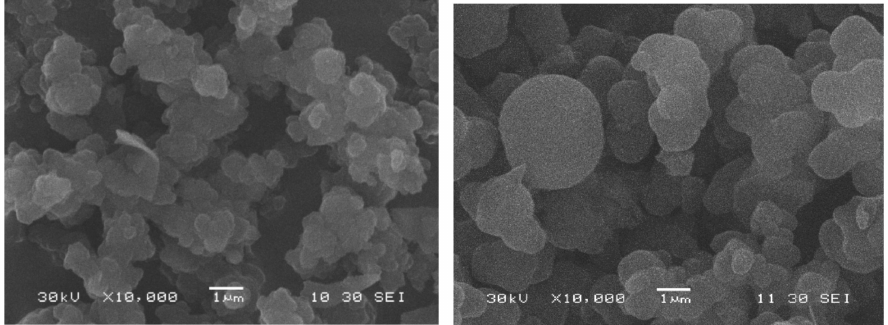
Figure 4. Scanning electron microscopy (SEM) images of FcCMP-1 (left) and FcCMP-2